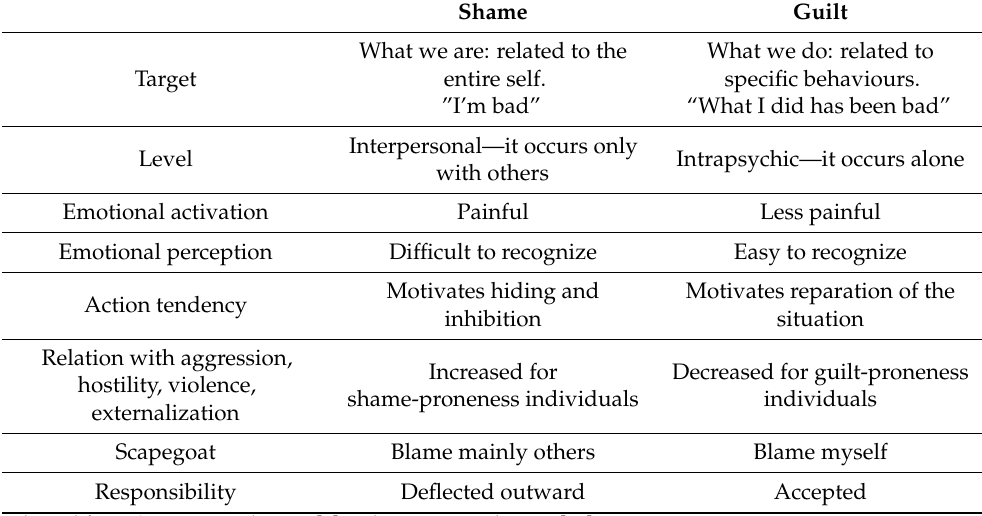
What we do: related to specific